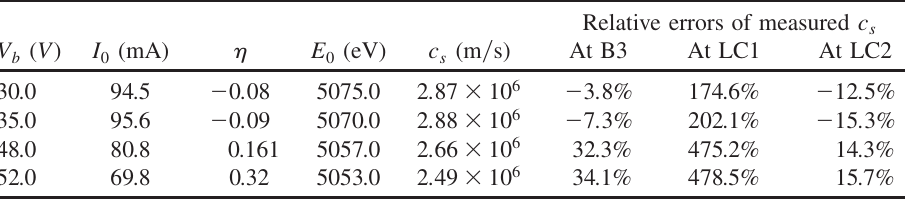
TABLE II. Parameters of current and energy profiles and calculation of sound speed.